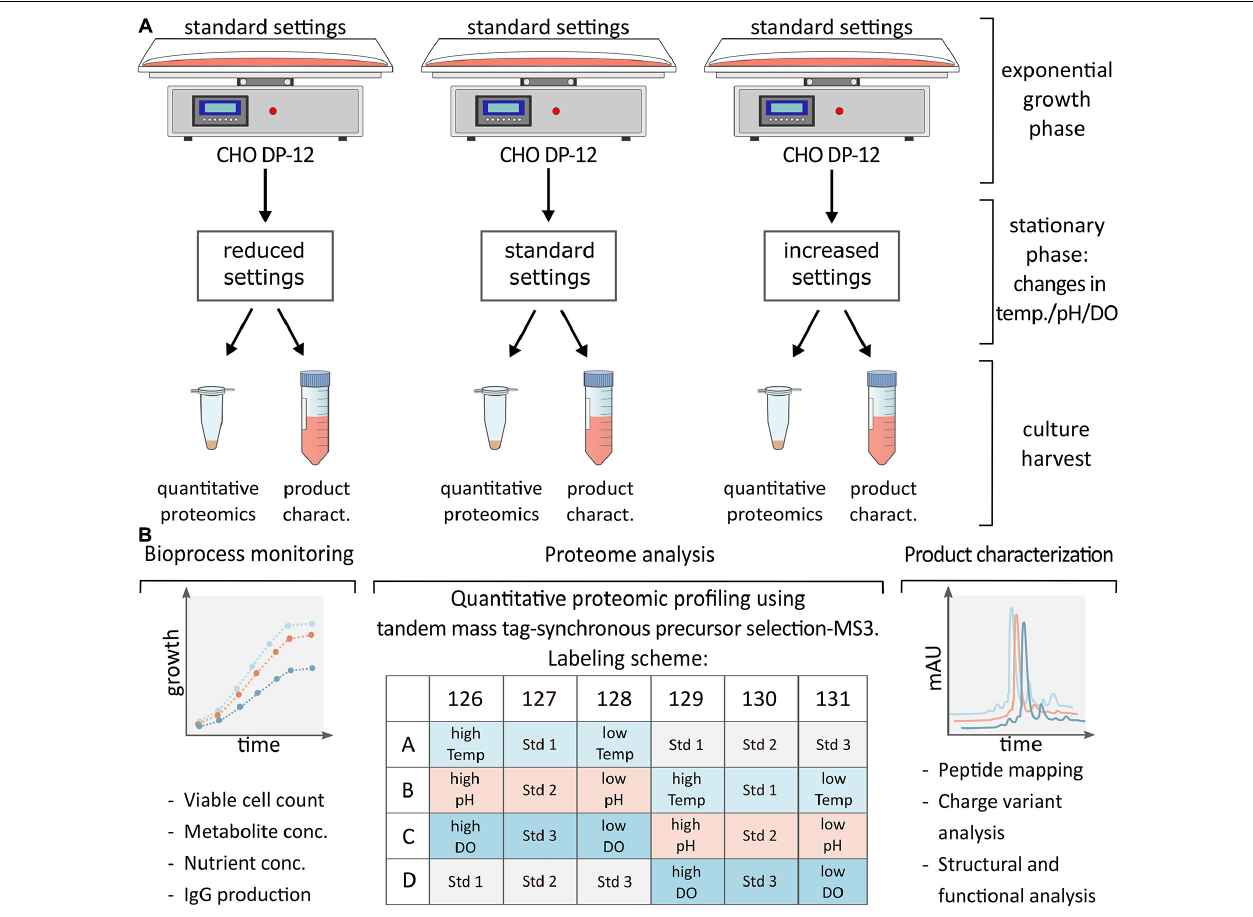
FIGURE 1 | (A) CHO DP-12 cells were grown under standard conditions until cells entered stationary phase (day 5) then process parameters were changed as shown followed by cell harvest and supernatant collection after 48 h. (B) Schematic overview of analysis following cell harvest. Bioprocess monitoring was carried out on a daily basis to assess viable cell density, metabolite or nutrient concentration and IgG production rate. Following batch culture, cells were lysed, and samples were prepared for quantitative proteomic profiling applying TMT labeling as indicated. Complementary product characterization was done to detect sequence variants, modifications, and structural